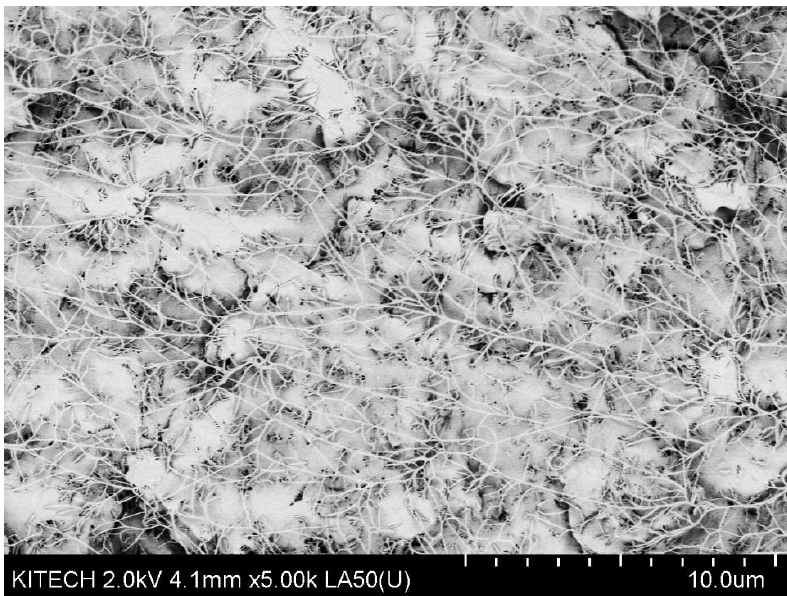
Figure A4. SEM image of the 3.66 wt.% SWNT/PP composite.